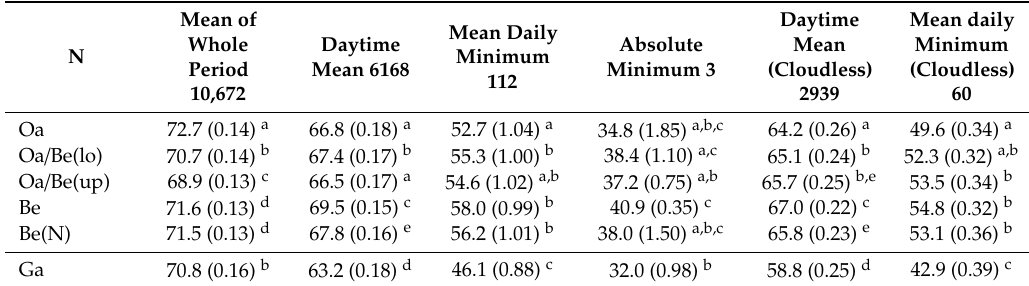
Table 4. Mean relative air humidity (RH, in %), mean daytime RH, mean daily RH minimum, and mean absolute minimum (with SE in brackets) at the five measuring points in the forest and in the gap, averaged over the three transects. The daytime period refers to 9 a.m.–9 p.m. Significantly di ff erent means are marked with di ff erent small letters. The first four columns refer to all days of the measuring period, the last two columns only to days with less than 50% cloudiness and no rain (cloudless). N gives the number of individual 15-min values used for